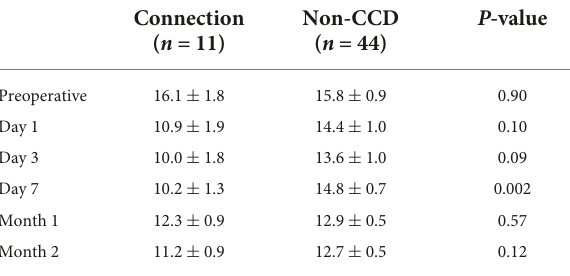
TABLE 5 Time course for the IOP in the connection group eyes (eyes with a connection between the anterior chamber and the CCD) and in the non-CCD group